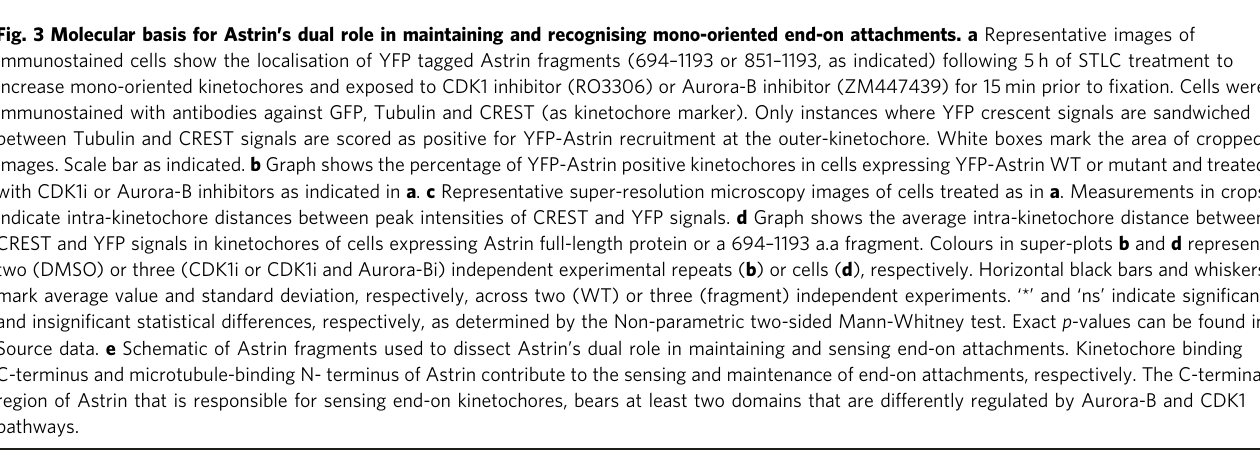
Fig. 3 Molecular basis for Astrin ’ s dual role in maintaining and recognising mono-oriented end-on attachments. a Representative images of immunostained cells show the localisation of YFP tagged Astrin fragments (694 – 1193 or 851 – 1193, as indicated) following 5 h of STLC treatment to increase mono-oriented kinetochores and exposed to CDK1 inhibitor (RO3306) or Aurora-B inhibitor (ZM447439) for 15 min prior to fi xation. Cells were immunostained with antibodies against GFP, Tubulin and CREST (as kinetochore marker). Only instances where YFP crescent signals are sandwiched between Tubulin and CREST signals are scored as positive for YFP-Astrin recruitment at the outer-kinetochore. White boxes mark the area of cropped images. Scale bar as indicated. b Graph shows the percentage of YFP-Astrin positive kinetochores in cells expressing YFP-Astrin WT or mutant and treated with CDK1i or Aurora-B inhibitors as indicated in a . c Representative super-resolution microscopy images of cells treated as in a . Measurements in crops indicate intra-kinetochore distances between peak intensities of CREST and YFP signals. d Graph shows the average intra-kinetochore distance between CREST and YFP signals in kinetochores of cells expressing Astrin full-length protein or a 694 – 1193 a.a fragment. Colours in super-plots b and d represent two (DMSO) or three (CDK1i or CDK1i and Aurora-Bi) independent experimental repeats ( b ) or cells ( d ), respectively. Horizontal black bars and whiskers mark average value and standard deviation, respectively, across two (WT) or three (fragment) independent experiments. ‘ * ’ and ‘ ns ’ indicate signi fi cant and insigni fi cant statistical differences, respectively, as determined by the Non-parametric two-sided Mann-Whitney test. Exact p -values can be found in Source data. e Schematic of Astrin fragments used to dissect Astrin ’ s dual role in maintaining and sensing end-on attachments. Kinetochore binding C-terminus and microtubule-binding N- terminus of Astrin contribute to the sensing and maintenance of end-on attachments, respectively. The C-terminal region of Astrin that is responsible for sensing end-on kinetochores, bears at least two domains that are differently regulated by Aurora-B and CDK1